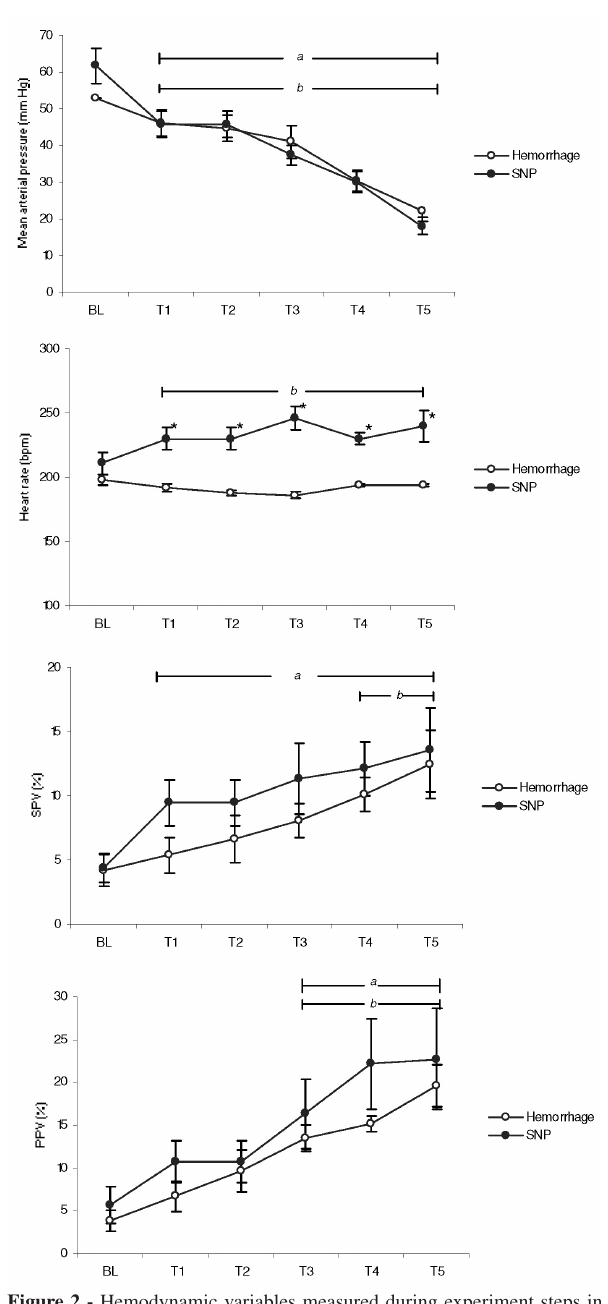
Figure 2 - Hemodynamic variables measured during experiment steps in the hemorrhage and nitroprusside (SNP) groups. Steps T1, T2, T3, T4 and T5 correspond to 10%, 20%, 30%, 40% and 50% of blood removal from estimated volemic state (hemorrhage group). In the SNP group, mean arte- rial pressure (MAP) achieved corresponds to the MAP observed at each bleeding step set in the hemorrhage group. Bars “a” (Hemorrhage) and “b” (SNP) correspond to p < 0.05 to baseline (Student’s t -test). An asterisk shows statistical differences (p < 0.05) between groups (ANOVA